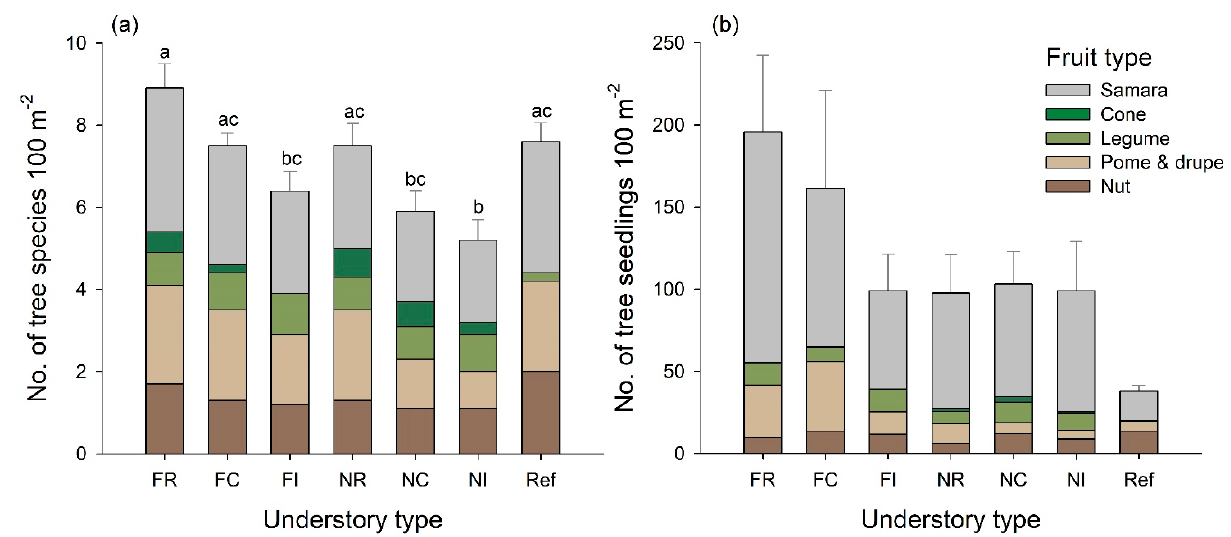
Figure 6. Tree regeneration in the stands with different understory types. ( a ) Tree seedling richness, and ( b ) number of tree seedlings in 2020. The values with different letters indicate significant difference at p < 0.05. The values are average ± standard error. FR: flowering and rooting, FC: flowering and cutting, FI: flowering and intactness, NR: non- flowering and rooting, NC: non-flowering and cutting, NI: non-flowering and intactness, Ref: reference.